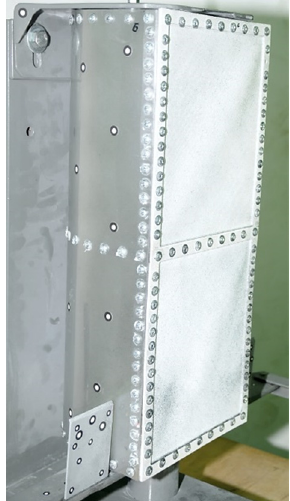
Figure 16. View of the wall deformation at the maximum load value (156 N).